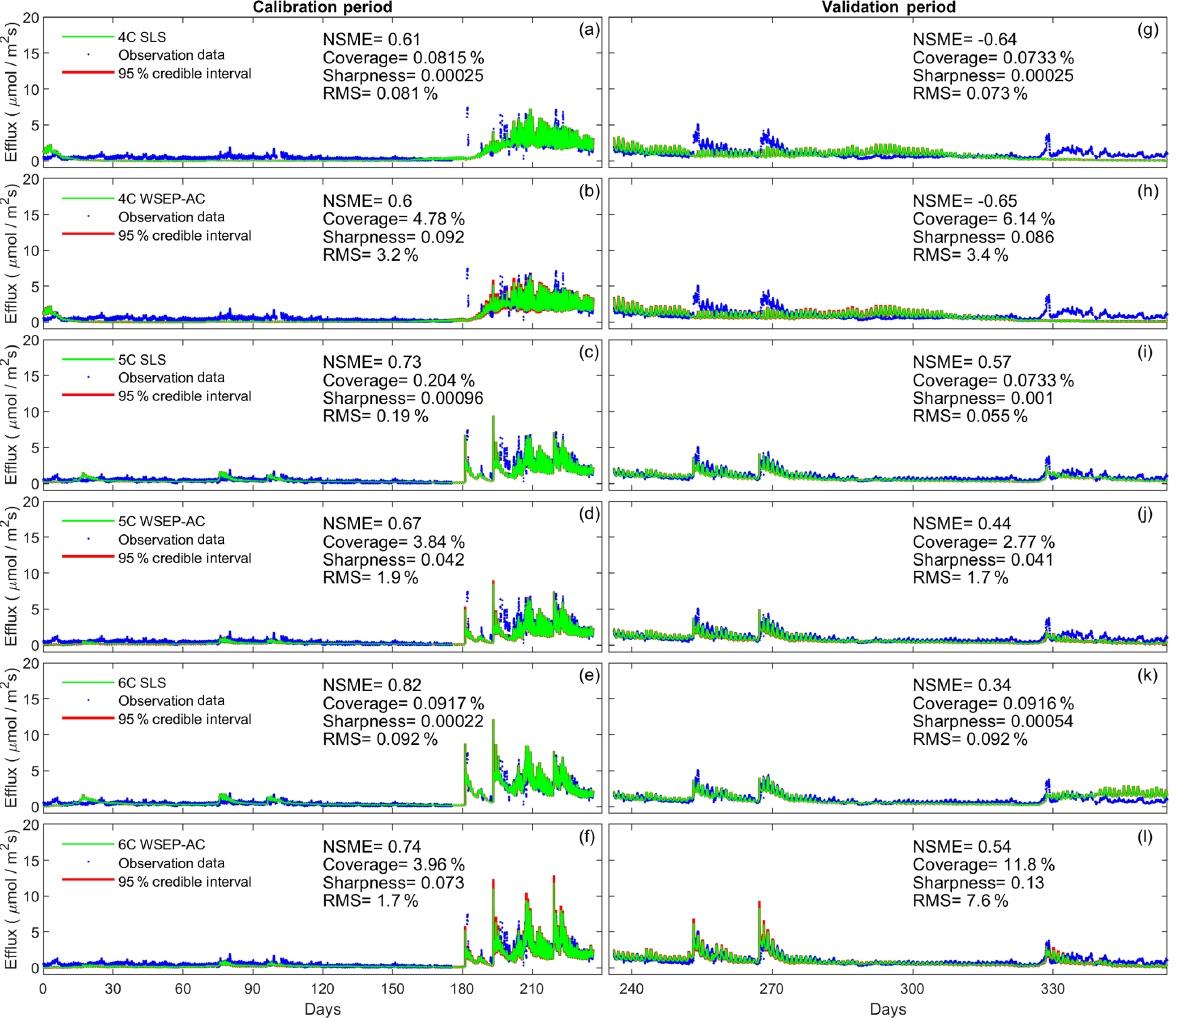
Figure 6. Observation data (blue dots), mean prediction (green line), and 95% credible intervals (red line) of prediction ensembles for (a–f) the calibration period and (g–l) the validation period. The plots are for the three soil respiration models using the SLS and WSEP- AC data models. The prediction ensembles are generated to consider parametric uncertainty of the soil respiration models only. The model prediction accuracy, reliability, dispersion and overall predictive performance are measured by the Nash–Sutcliffe model efficiency (NSME), the predictive coverage metric (“Coverage”), the sharpness metric (“Sharpness”) and the relative model score (RMS),